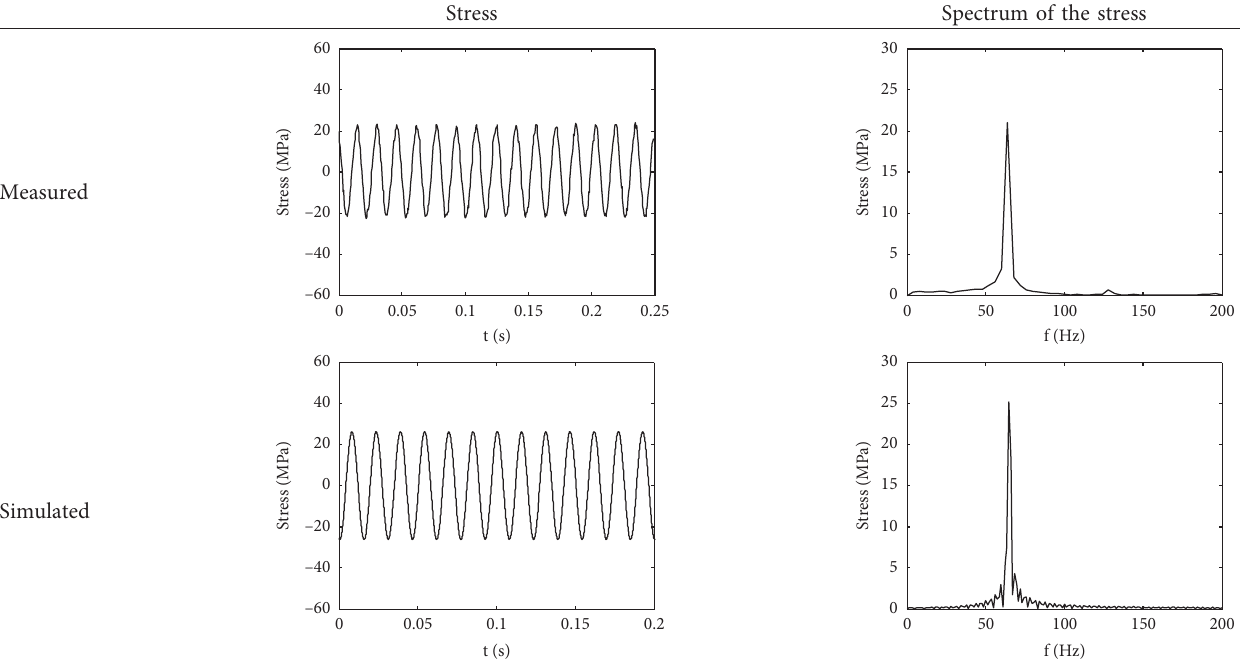
Figure 10: Tested point of stress on the squirrel cage. (a) Tested point. (b) Corresponding tested point in the model. Table 9: Comparison of stress on the squirrel cage under normal condition ( h � 0